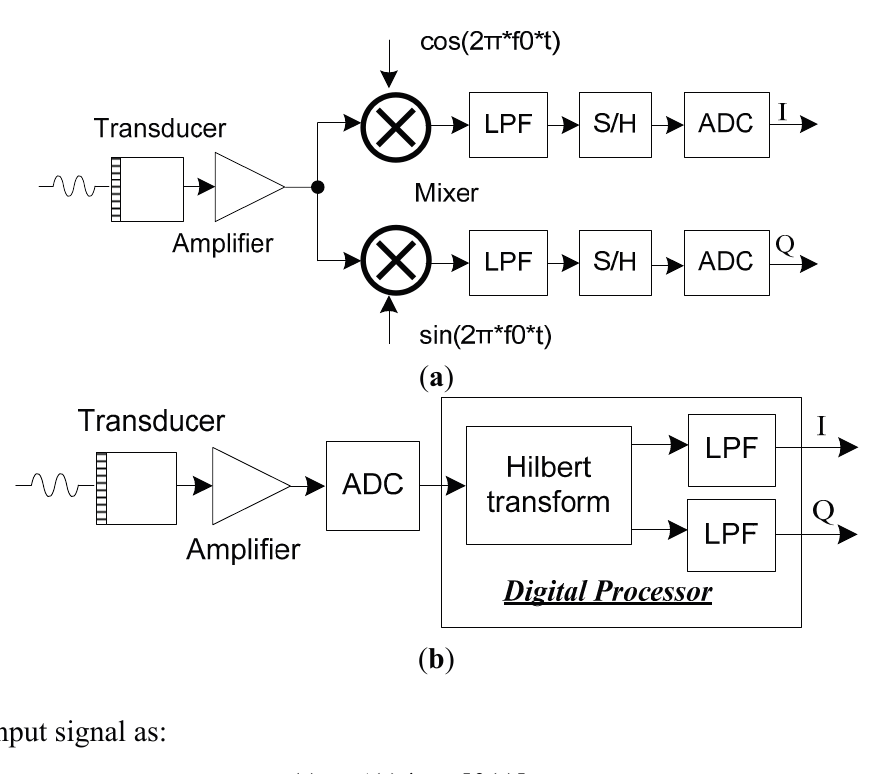
Figure 1. Different schemes for PW Doppler. ( a ) Conventional analog demodulation; ( b ) Hilbert transform based quadrature demodulation method.